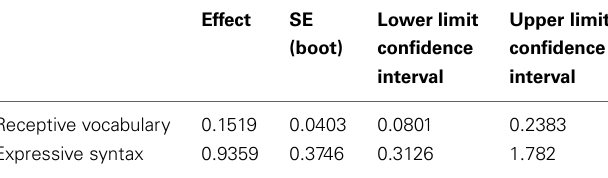
Table 7 | Indirect effect of predictor variables to reading comprehension.